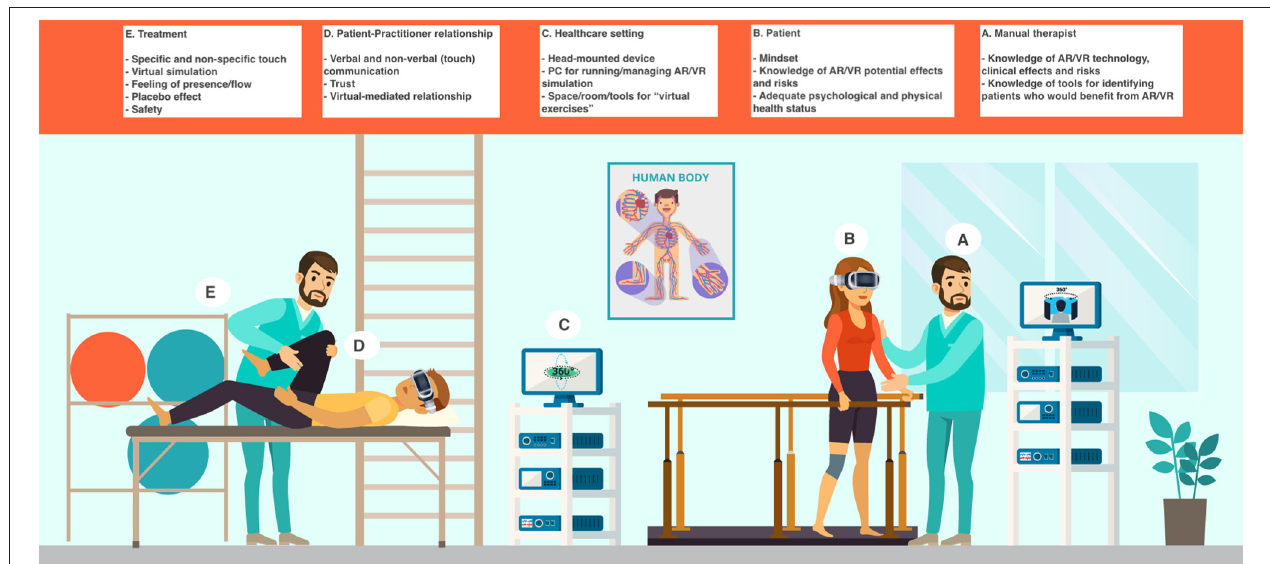
FIGURE 1 | The integration of VR and AR in the MT setting. The MT setting would be enhanced by the addition of VR and AR: however, this implies the therapist and the patient need to pay attention to both old and new therapeutic factors. The factors could be summarized as follows (see the section “The Crossroads between MTs, VR and AR,” for further information). (A) Manual therapist’s features: knowledge of AR and VR technology, clinical effects and risks; knowledge of tools (e.g., questionnaires, biomarkers such as heart rate variability) for identifying patients who would benefit from AR or VR (every patient could respond differently to them and some patients could be at a higher risk of experiencing adverse effects, from cybersickness to depersonalization). (B) Patient’s features: mindset (i.e., expectation about VR or AR positive effects); knowledge of AR and VR potential effects and risks; adequate psychological and physical health status (based on their psychophysical health, some patients could be at a higher risk of experiencing adverse effects, from cybersickness to depersonalization). (C) Healthcare setting: head-mounted device; PC (or other types of hardware) for running/managing AR or VR simulation; space/room/tools for “virtual exercises.” (D) Patient-practitioner relationship: verbal and non-verbal (touch) communication; trust (it is paramount when the patient is immersed in the virtual environment and, therefore, does not see the “real” therapist); virtual-mediated relationship (in the virtual simulation, there could be an avatar of the therapist and phenomena like the uncanny valley could happen). (E) Treatment features: specific (technical) and non-specific (placebo) touch; virtual simulation; feeling of presence/flow (necessary for an optimal AR and VR experience); placebo effect (the patient could feel better just due to the simple fact that an “awesome” technology is being used);